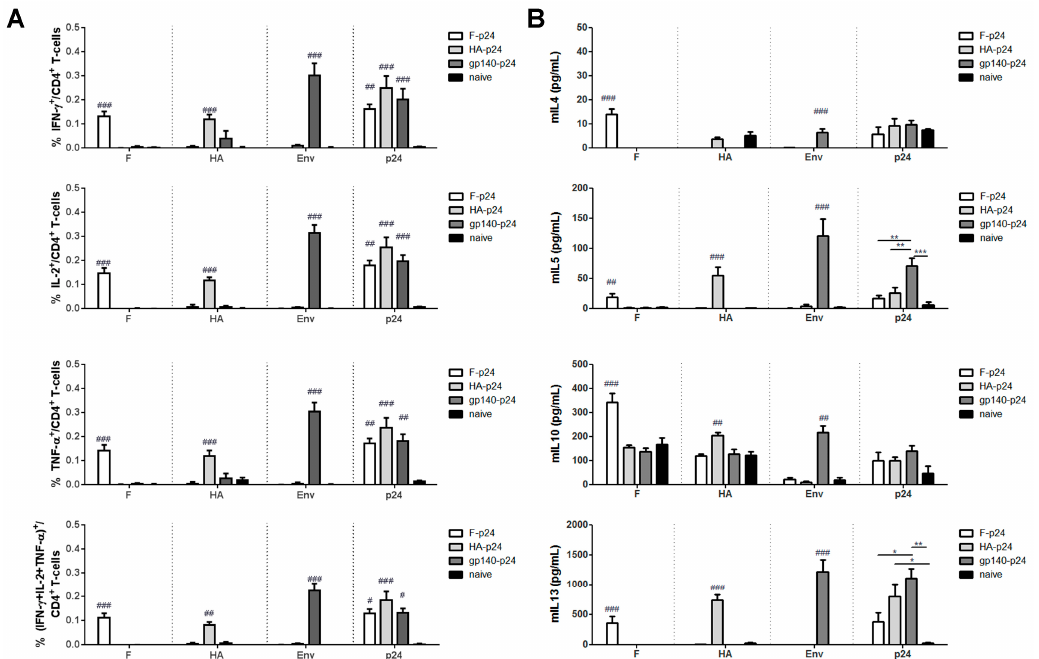
Figure 4. Cellular responses induced by DNA vaccines encoding p24 fusion proteins. Balb/c mice were immunized twice with DNA vaccines coding for the p24 fusion-proteins and antigen-specific CD4 + T-cell responses were analyzed two weeks after the booster immunization. Intracellular cytokine staining was used for the detection of the typical TH1 cytokines. The percentages of IFN- γ , TNF- α , and IL-2 producing CD4 + T-cells as well as polyfunctional triple positive cells are depicted in ( A ). The peptide used for the in vitro re-stimulation is shown at the x-axis of each graph. The analysis of TH2 cytokines was performed by cytokine specific ELISAs ( B ). In each graph, the bars represent the mean values with SEM of 4–6 mice (# p < 0.05 vs. naïve, ## p < 0.01 vs. naïve, ### p < 0.001 vs. naïve; * p < 0.05, ** p < 0.01, *** p < 0.001; one-way ANOVA with Tukey’s post-test).